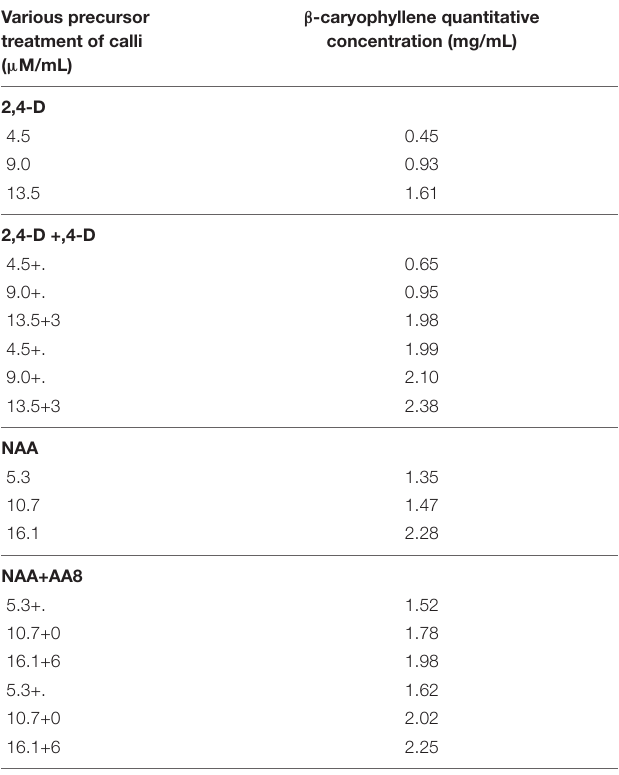
TABLE 4 | Different concentrations of with and without precursor treated hairy root samples quantified by GC-MS. Various precursor treatment of hairy root culture ( µ M/mL)